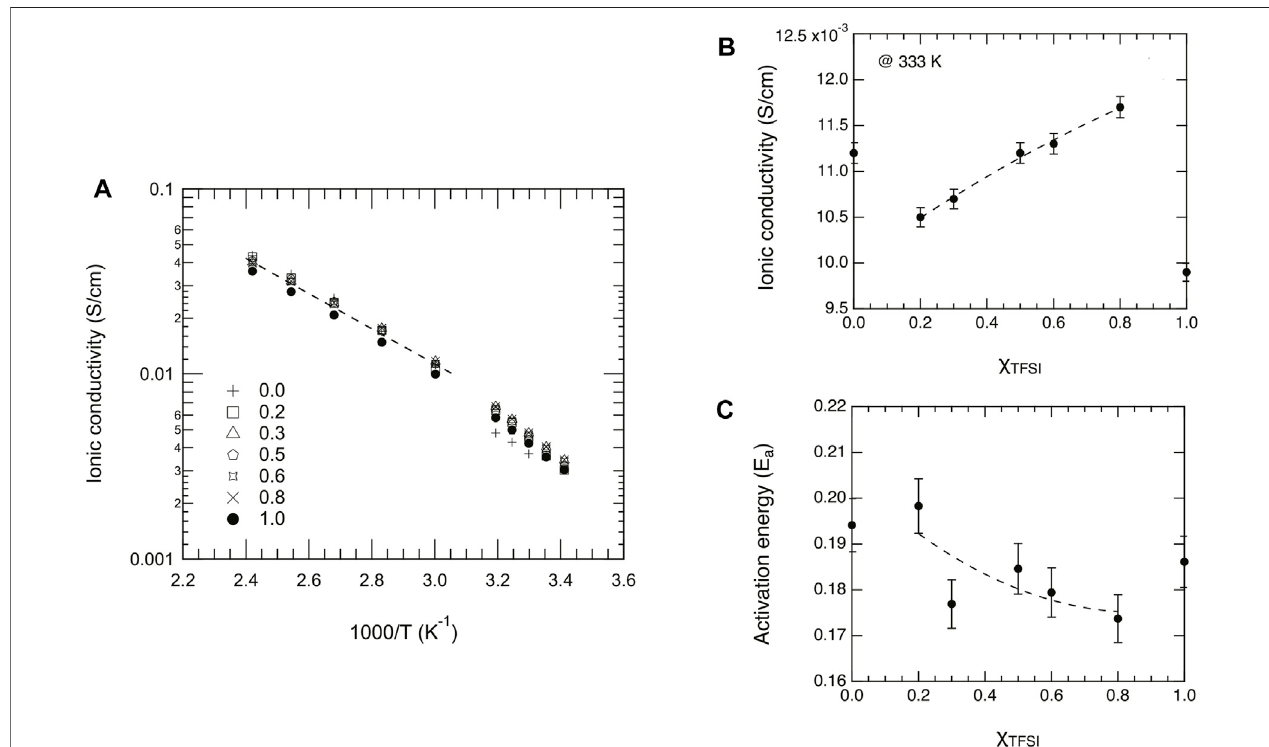
FIGURE 9 | (A) Arrhenius plot of the dc ionic conductivity as a function of reciprocal temperature and for different mole fractions, χ , of [C 2 HIm][TFSI]. (B) Ionic conductivityextrapolatedforthedifferentliquidsatthetemperatureof333 K. (C)